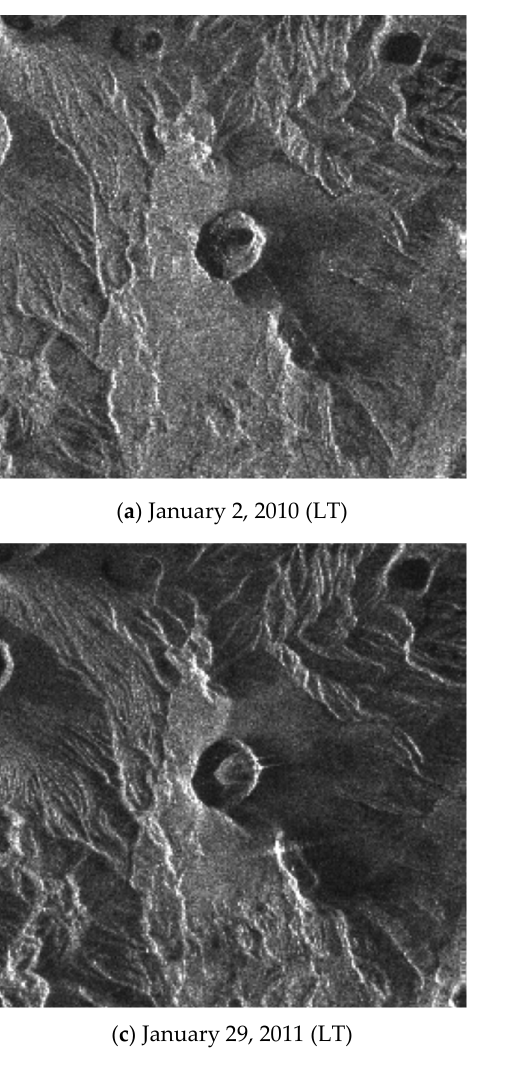
Figure A3. ALOS/PALSAR images of the summit crater of Shinmoedake (after JMA (Japan Meteorological Agency) report [29]). ALOS means Advanced Land Observing Satellite and the PALSAR aboard ALOS is Phased Array type L-band Synthetic Aperture Radar (SAR) sensor. ( a ) 2 January 2010. A photo about one year before the 2011 eruption. The existence of the crater lake can be confirmed; ( b ) 27 January 2011. The existence of a small bulge or a small rise in the center of the crater can be confirmed; ( c ) 29 January 2011. Discharged lava grew and a lava dome can be confirmed in the center of the crater; ( d ) 1 February 2011. Discharged lava fills the crater and the diameter of lava is about 500 m.